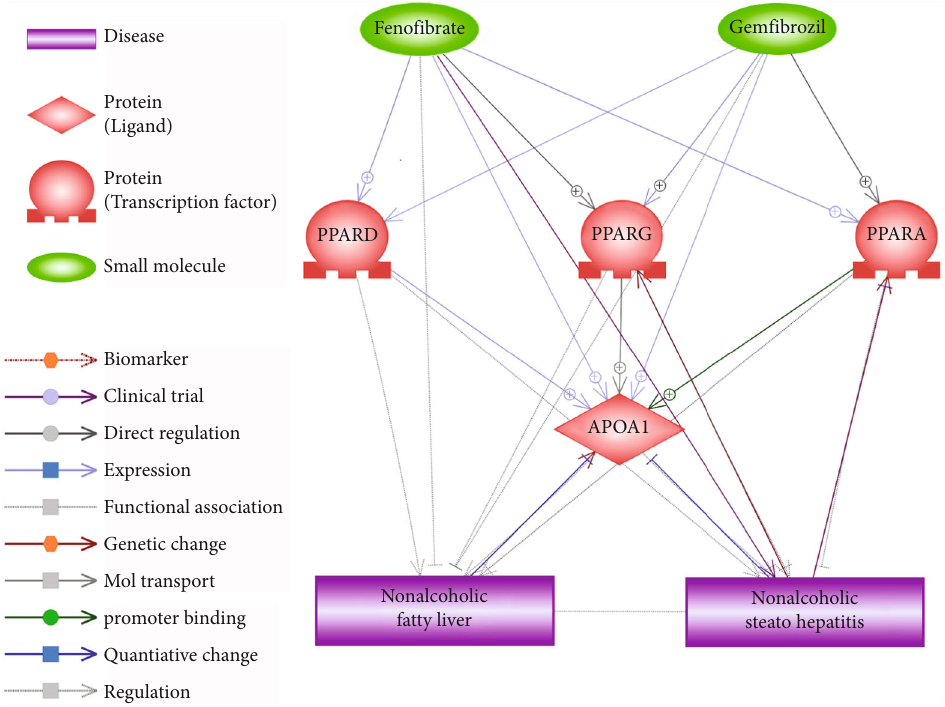
Figure 1: PPAR-APOA1 signaling pathway regulating nonalcoholic fatty liver